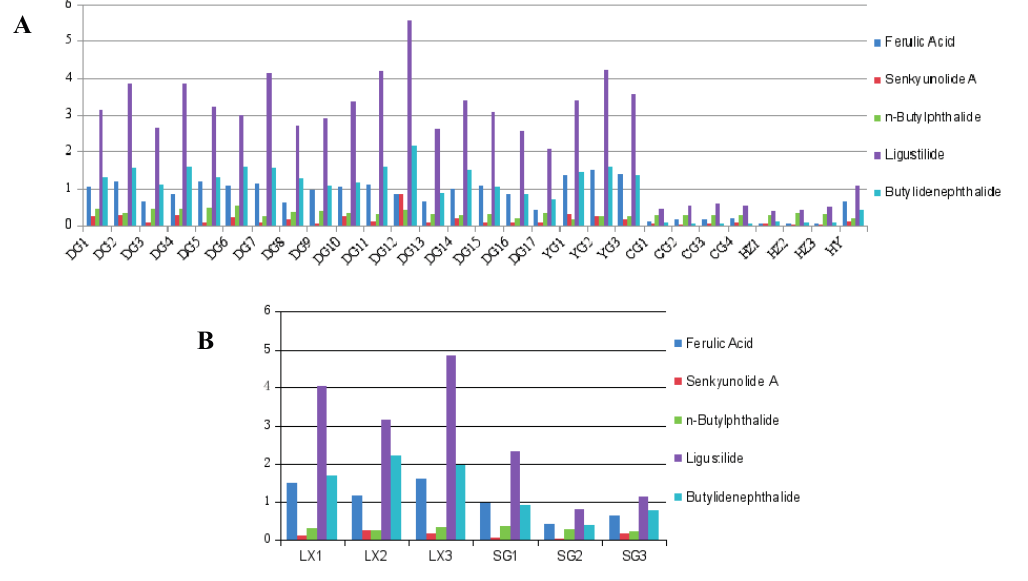
Figure 4. The content of ferulic acid and phthalides in Angelica sinensis from different regions ( A ) and processed Angelica sinensis ( B ). Non-fumigated: LX1, LX2, LX3; sulfur-fumigation: SG, SG2,